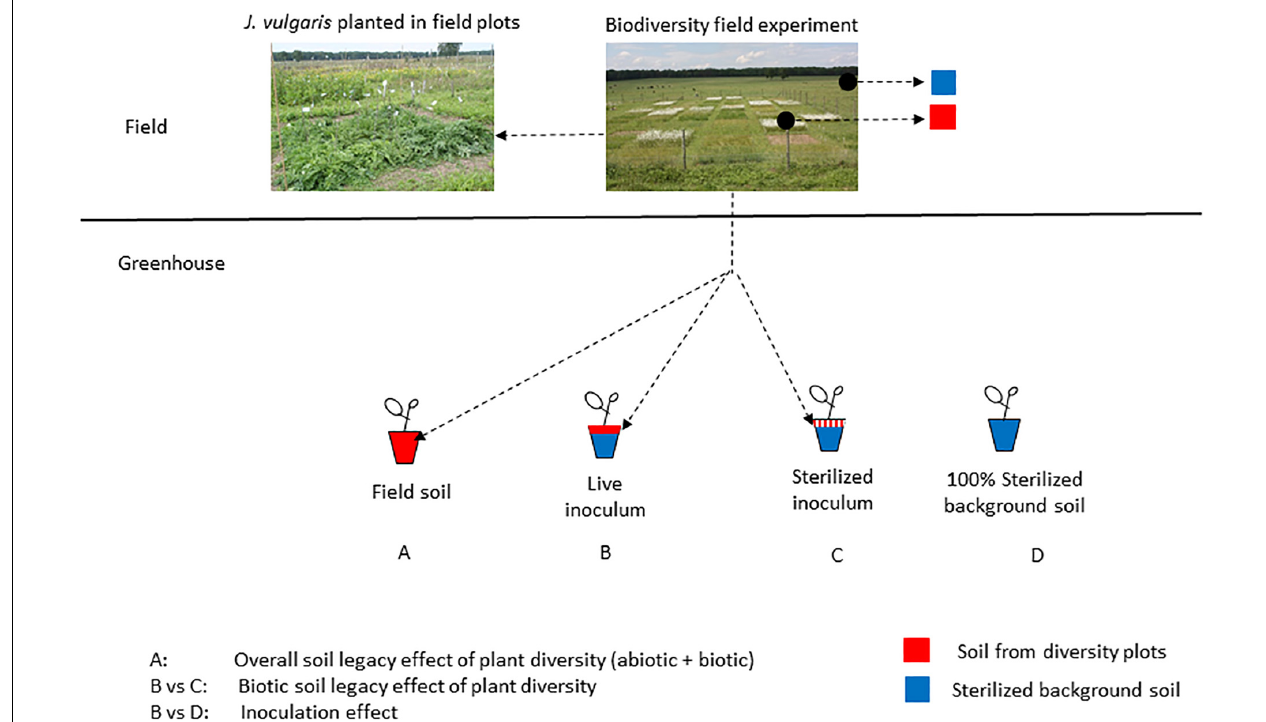
FIGURE 1 | Schematic overview of the experimental setup. Soil was collected from field plots that differed in plant diversity (0, 1, 2, 4, 9 species) and the legacy effect of these soils on J. vulgaris was determined in a pot experiment (pure field-conditioned soil; sterilized background soil mixed with live inoculum; sterilized background soil mixed with sterilized inoculum). The effects were compared to the performance of J. vulgaris planted in the plots (left photo shows J. vulgaris in a bare plot).